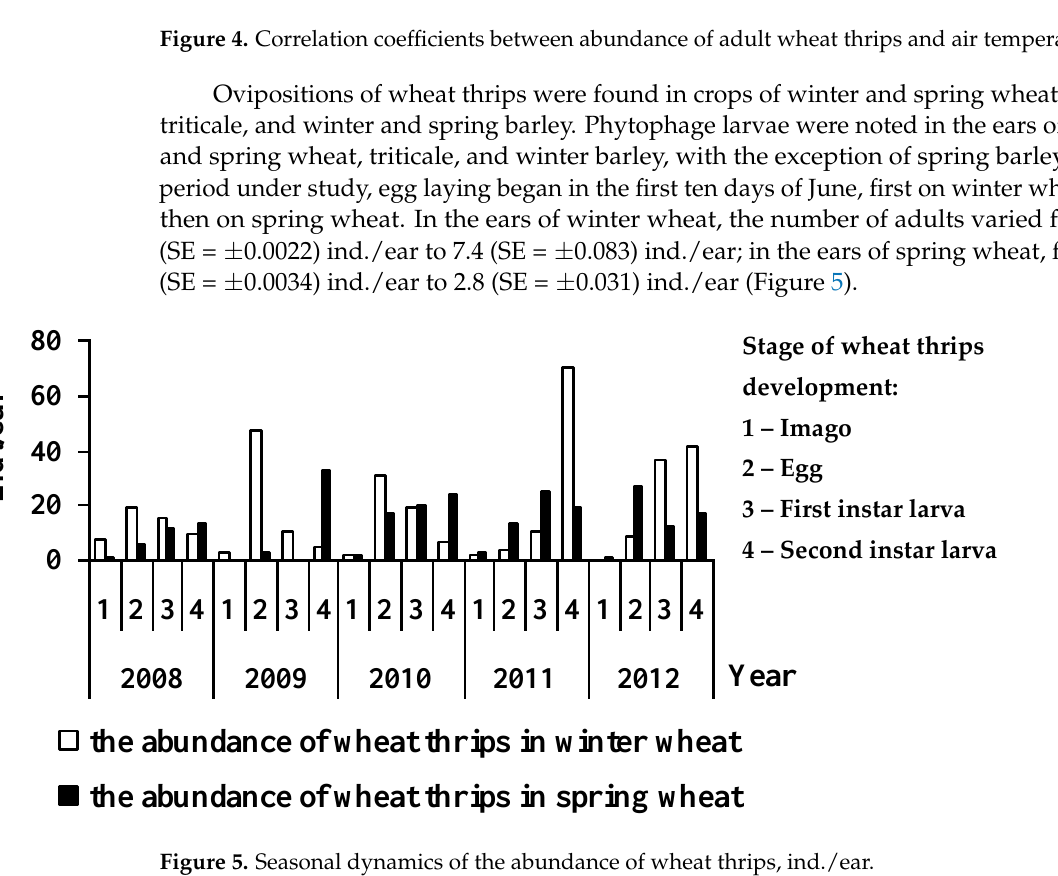
Figure 5. Seasonal dynamics of the abundance of wheat thrips, ind./ear. The number of eggs laid in winter wheat crops varied over the years from 4.2 (SE = ±0.047) to 46.8 (SE = ±0.523) ind./ear. The duration of the intensive oviposition stage av- eraged 7 – 11 days. Starting from the second ten-day period of June, wheat thrip larvae of the first and then the second instars were diagnosed in the ears of winter and spring wheat. Their number varied over the years from 0.3 (SE = ±0.003) ind./ear to 70.5 (SE = ±0.787) ind./ear. The main factors in the departure of the second-age larvae of wheat thrips for wintering were a decrease in the moisture content of ripening grain and cal- endar dates. Note that differences in the abundance of wheat thrips in winter wheat are not sta- tistically significant at p = 0.05. The values of the F-criterion of the abundance of wheat thrips in winter wheat were F(3;16) = 1.7132; p = 0.2045. For spring wheat, the values of the F-criterion were F(3;16) = 5.873; p = 0.0067 allows us to speak about the difference in the average values characterizing the abundance of wheat thrips, the number of insects for the corresponding phases of crop development. Data on damage to wheat grain by wheat thrips are shown in Table 3. There is a weak degree of damage to the grain (slight expansion of the groove, brown spot, lighten- ing), an average degree of damage (deepening and expansion of the entire groove, brown color in its depth, light areas), and a strong degree (deformation of the entire grain, light color of the covers). In general, damage to winter wheat grain during the years of research varied from 55.3% (2011) to 69.2% (2009). At the same time, a weak de- gree of damage to the grain by the pest prevailed (2.3 – 47.6%), with the exception of 2012 at 32.0%, a strong degree of damage. Table 3. The degree of damage to the grain of winter and spring wheat in 2008 – 2012, %. Years